Question: Identify the chart type used in this figure.
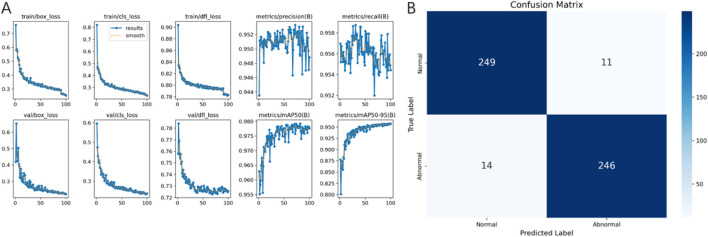
Answer: heatmap